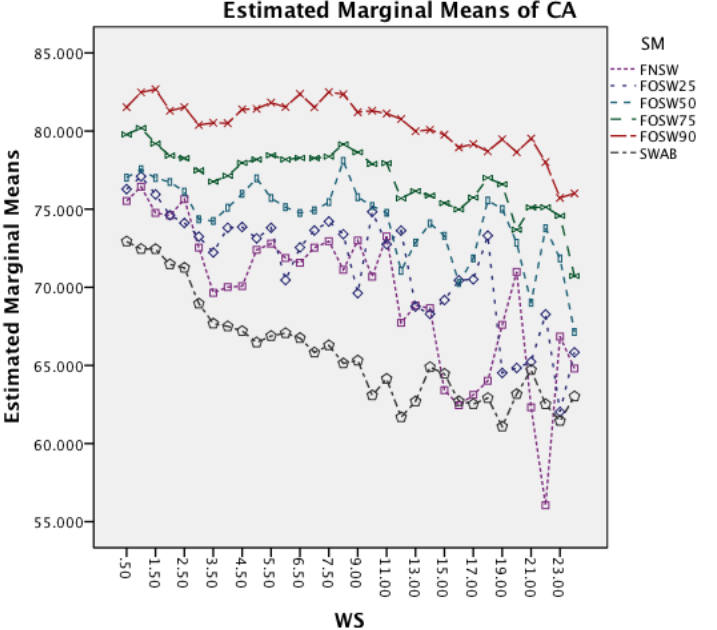
Figure 9. Two-way interaction effect for WS and